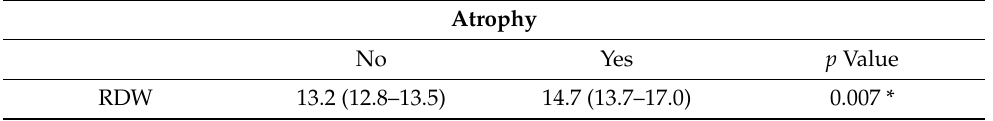
Table 6. Association between RDW with atrophy grade